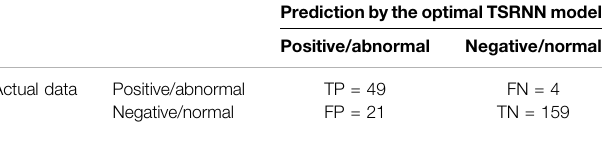
TABLE 3 | Confusion matrix of the discriminating results predicted by the optimal TSRNN model for the 233 test samples. Predictionbythe optimalTSRNN